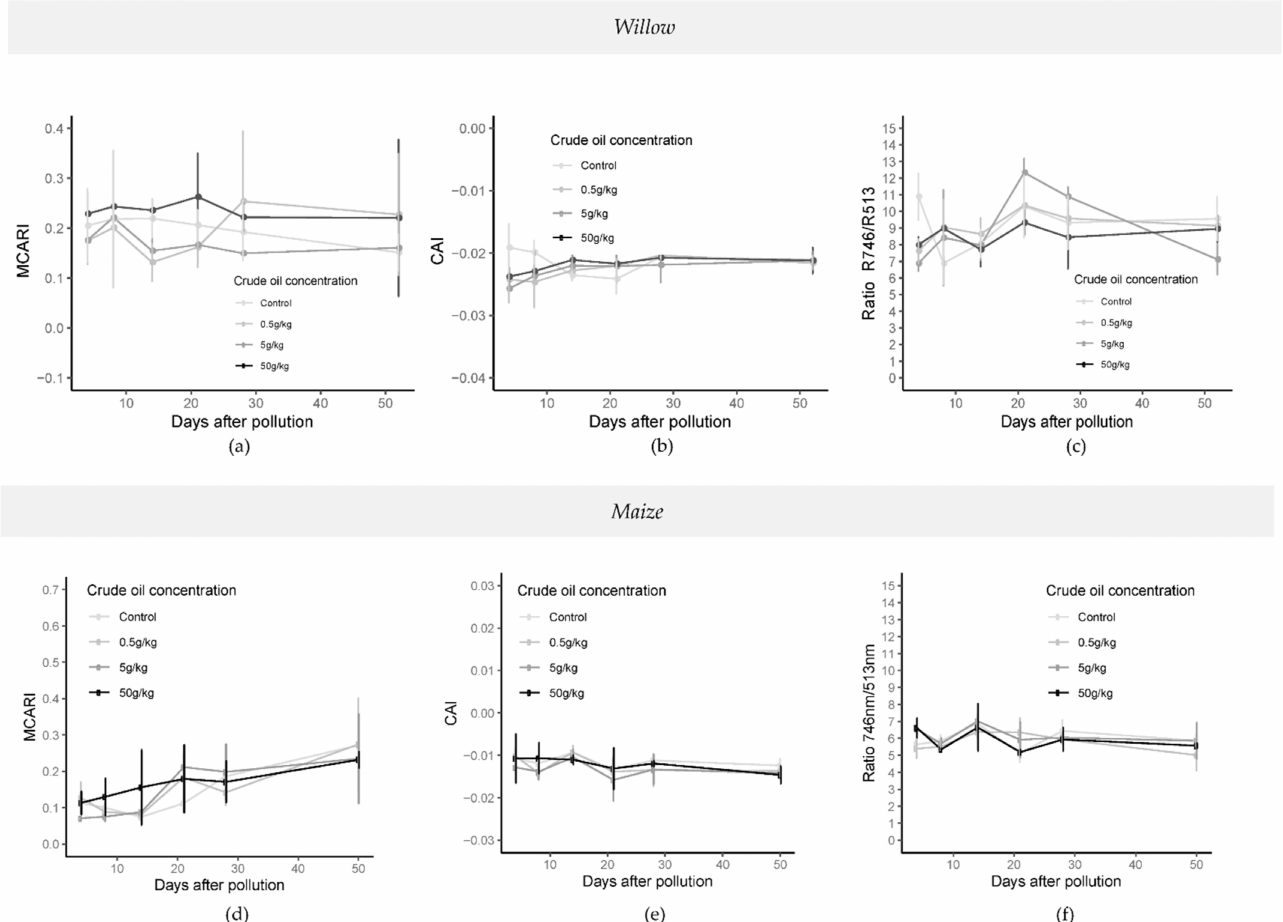
Figure 8. Time series of vegetation indices MCARI ( a , d ), CAI ( b , e ), and RARS ( c , f ) in crude oil treatments in willow (top) and maize (bottom) from 4 days after the addition of the polluted layer until 50 days later. (MCARI: modified chlorophyll absorption reflectance index, CAI: cellulose absorption index). Last spectral measurement of willow was 52 days after the addition of the pollution and last day in the maize experiment was 50 days after the addition of the